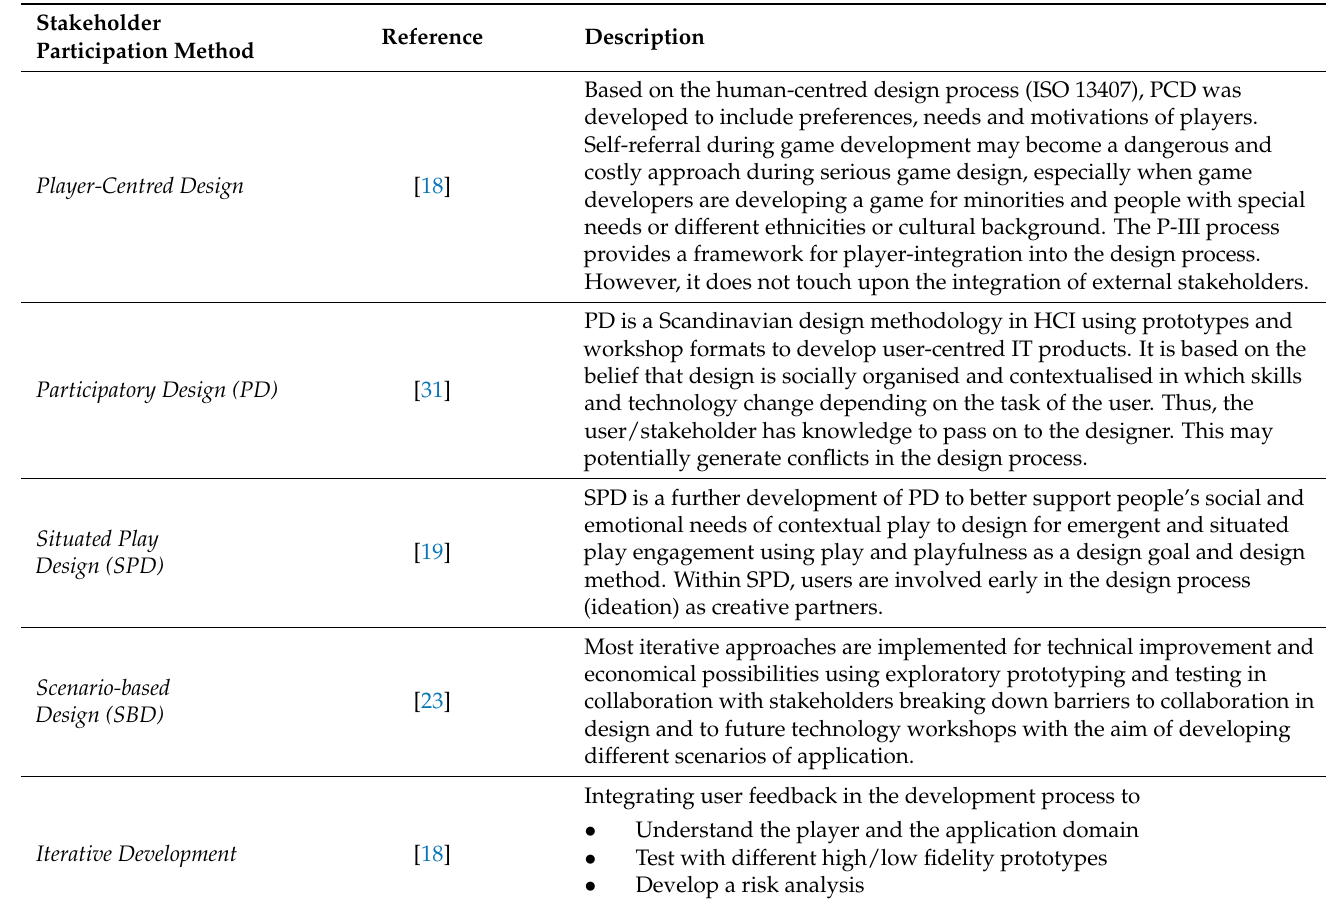
Table 1. Overview of stakeholder participation